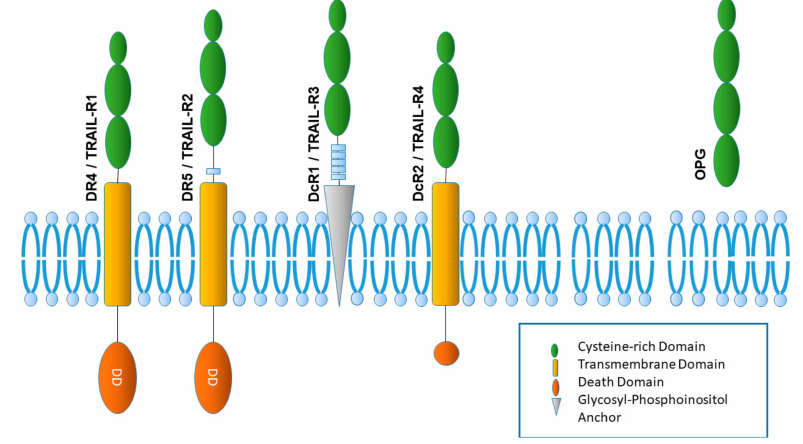
Figure 1. The human TRAIL receptor system. In humans, two TRAIL receptors are known to possess a functional death domain and thus can induce apoptosis: TRAIL receptor 1 (TRAIL-R1, DR4) and TRAIL receptor 2 (TRAIL-R2, DR5). Besides these are two other membrane-bound TRAIL receptors serving as decoy receptors: TRAIL receptor 3 (decoy receptor 1, DcR1) has no intracellular domain, while TRAIL receptor 4 (DcR2) contains a truncated death domain. In addition to the four membrane-bound TRAIL receptors, there is a soluble receptor known as osteoprotegerin